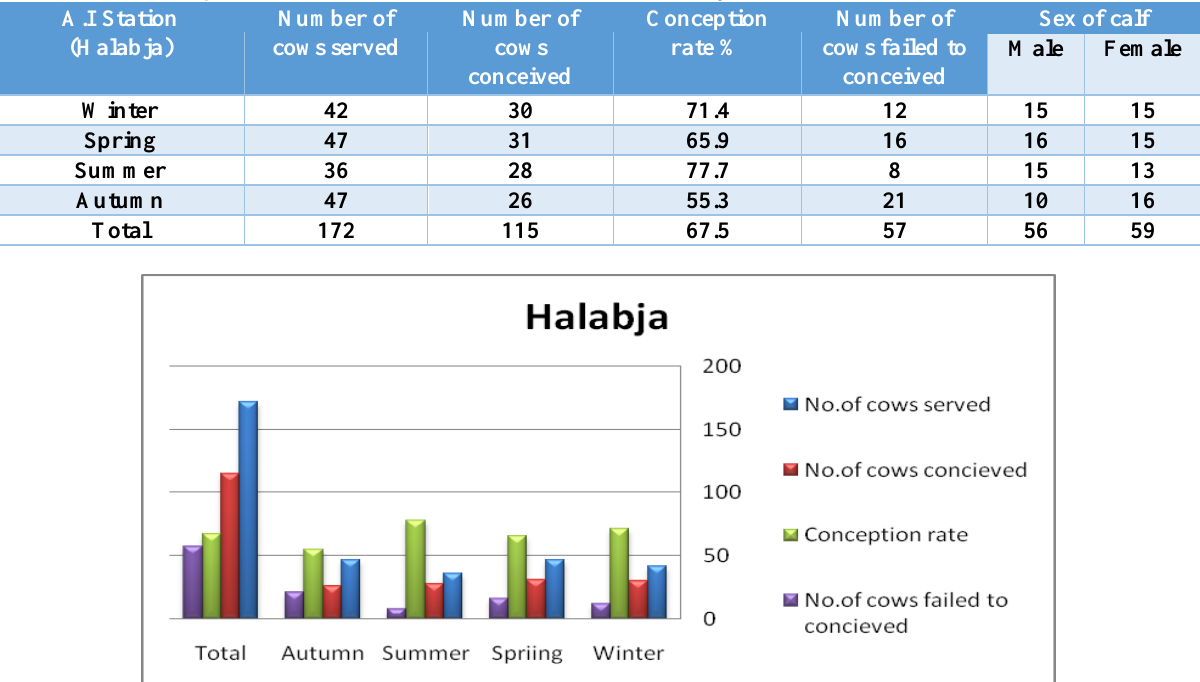
Figure, 2: The conception rate calf sex in different seasons for Halabja station.